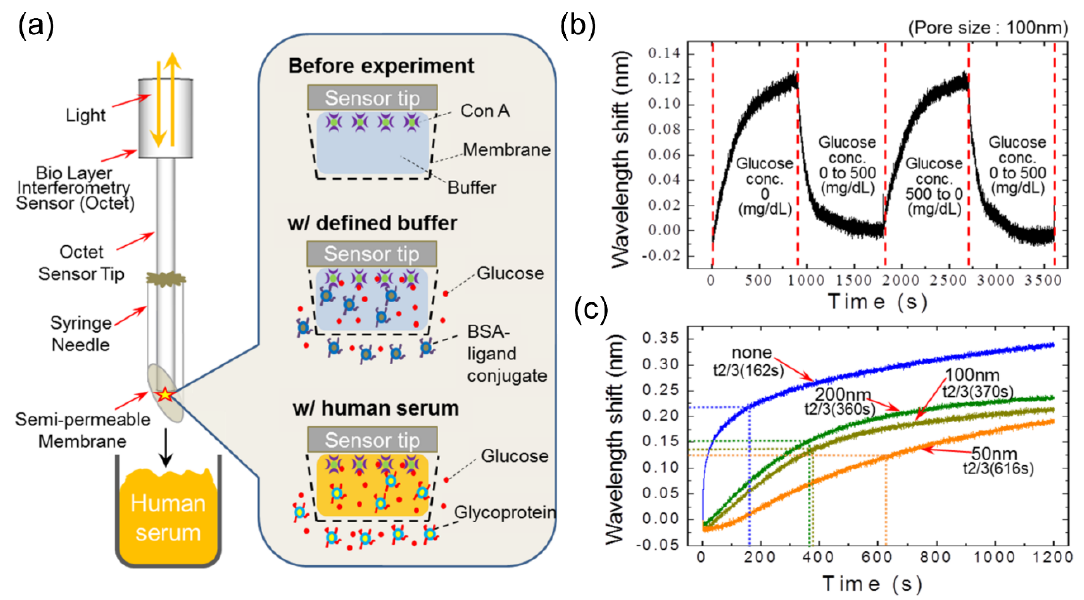
Figure 15. ( a ) Schematic of the needle-type BLI sensor. ( b ) Real-time detection results with a glucose concentration of 500 mg/dL. ( c ) Responses for the different sizes of membrane pore. Reproduced from Open Access Article [96] in MDPI.